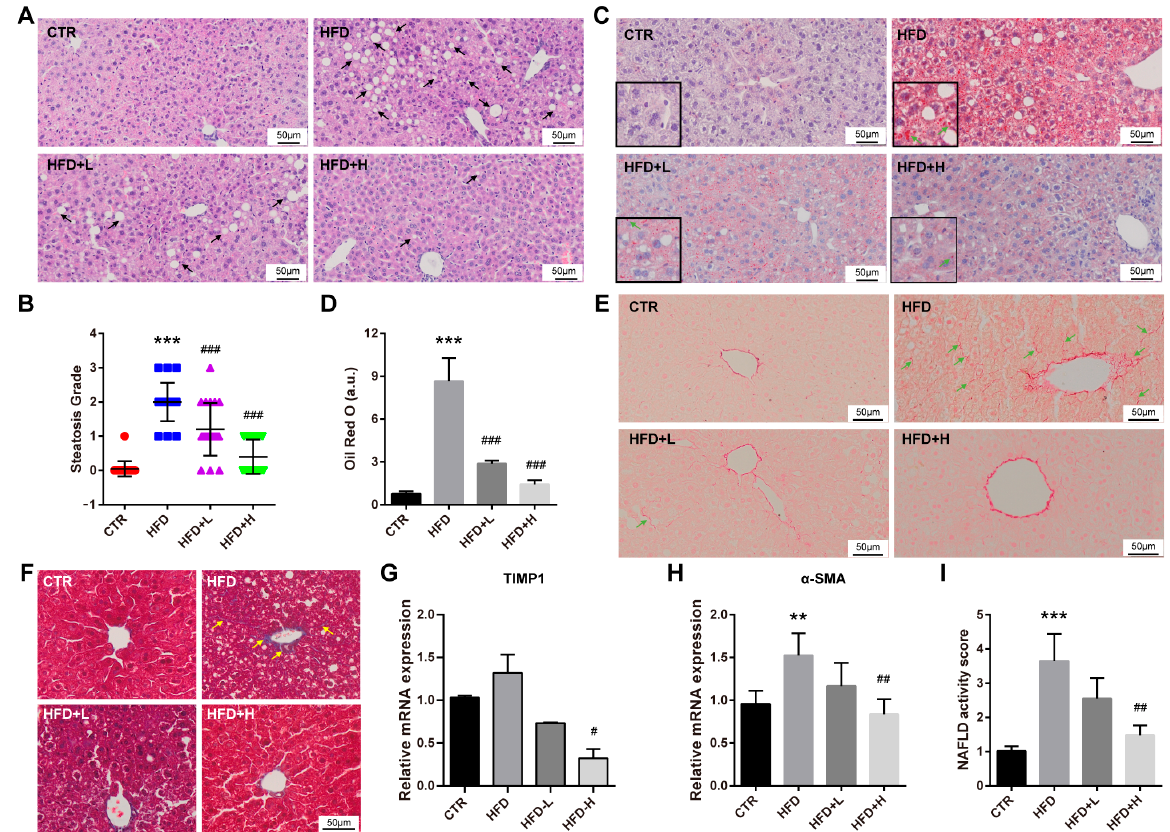
Figure 3. SMRR polysaccharide improves the progress of NAFLD. ( A , B ) Representative images of H&E staining and quantification show SMRR polysaccharide reverses the hepatocellular steatosis induced by high-fat diet. Error bars indicate SD; *** or ### p < 0.001 by one-way ANOVA. Arrows indicate hepatocellular steatosis. Different colors in ( B ) represent different groups. ( C , D ) Representative images of Oil Red O staining and quantification show SMRR polysaccharide reverses the hepatic lipid accumulation induced by high-fat diet. Error bars indicate SEM; *** or ### p < 0.001 by one-way ANOVA; a.u., arbitrary units. ( E , F ) Sirius Red staining ( E ) and Masson staining ( F ) show SMRR polysaccharide reverses the hepatic fibrosis induced by high-fat diet. Arrows indicate hepatic fibrosis. ( G , H ) qRT-PCR results show SMRR polysaccharide reverses the expressions of hepatic TIMP1 ( n = 3) and α -SMA ( n = 4) induced by high-fat diet. Error bars indicate SEM; # p < 0.05, ** or ## p < 0.01 by one-way ANOVA. ( I ) Quantification shows SMRR polysaccharide reverses the NAFLD activity score induced by high-fat diet. Error bars indicate SEM; ## p < 0.01, ** p < 0.001 by one-way ANOVA; n = 4; “*” stands for CTR vs. HFD, “#” stands for HFD vs. HFD+H.